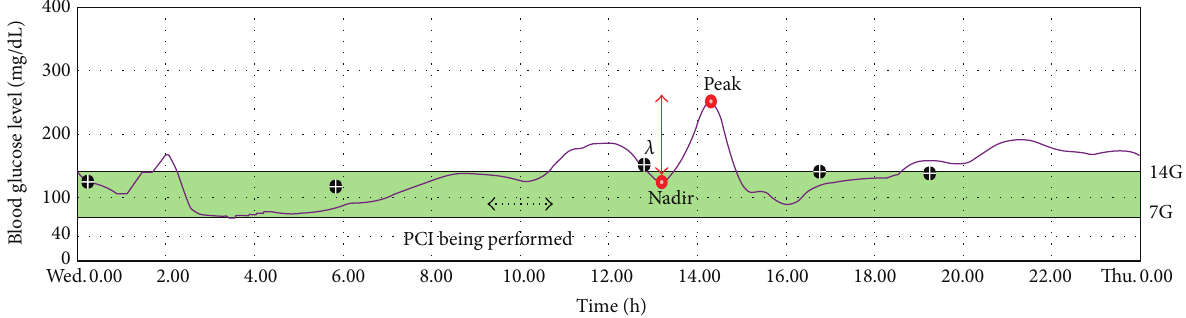
Figure 1: Example of 24-hour continuous glucose monitoring with i